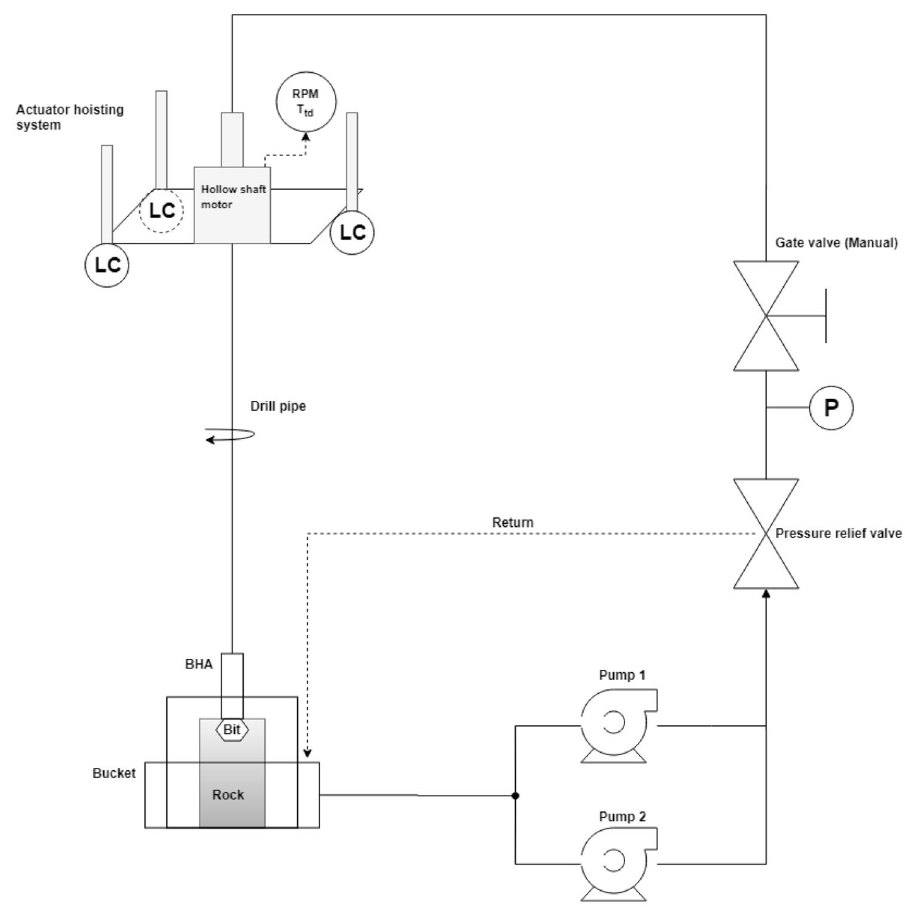
Fig. 2 Schematics of the rig